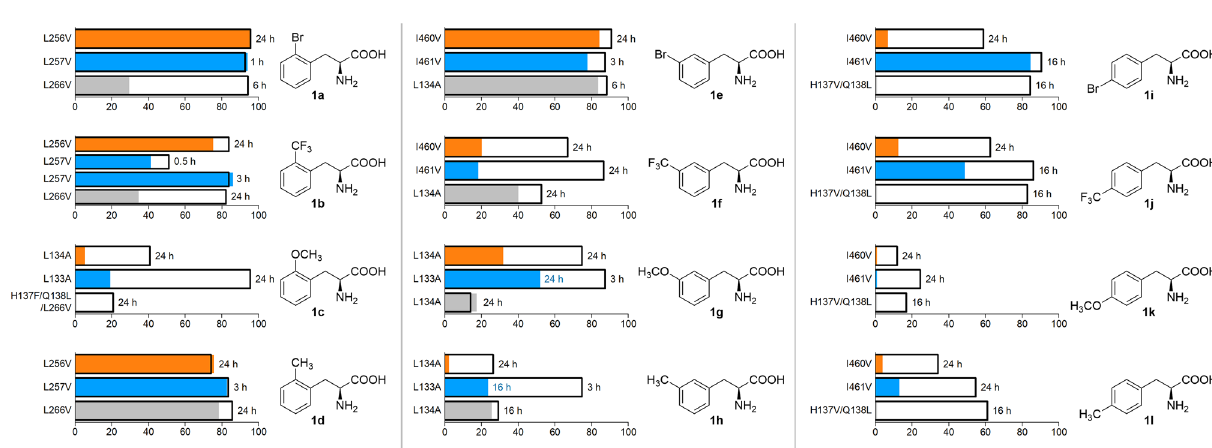
Figure 6. Conversion into l-phenylalanines l- 1a–l obtained within the ammonia additions reactions catalyzed by the wild-type Pc PAL (orange), At PAL (blue) and Rt PAL (grey) overlayed with the conversions provided by their best performing mutants (marked with non-filled boxes overlayed with the coloured lanes, representing the conversions of wild-type variants), evidencing the conversion-based activity increase provided by the mutations (white zone of each